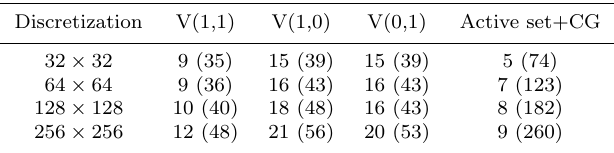
Table 2. Hertzian contact: the total number of active set iterations by MG+active set algorithm and the original method, with the numbers of work units in brackets. Discretization